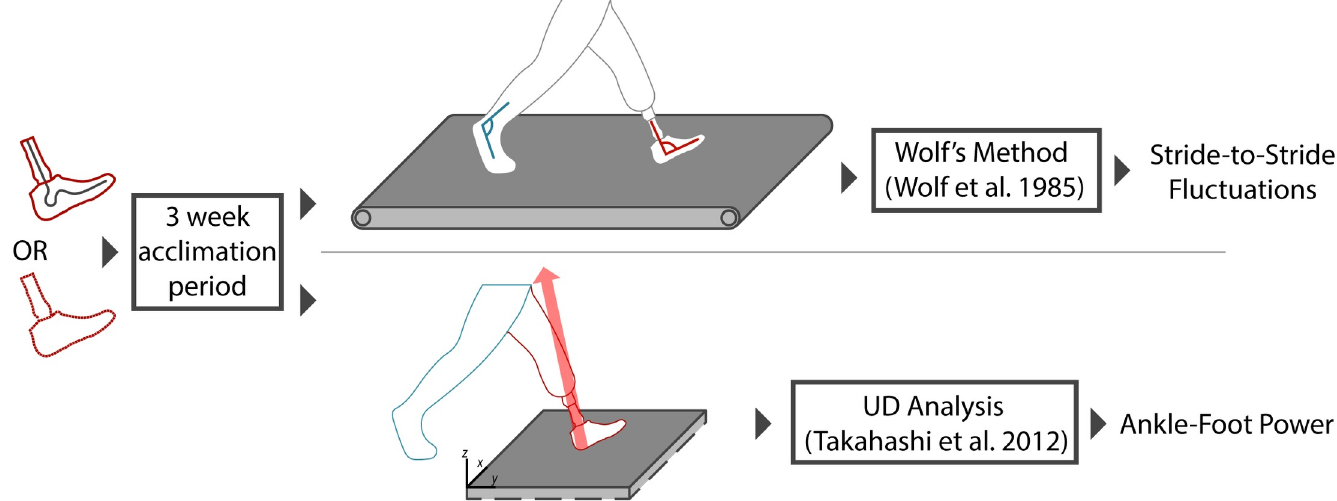
Fig 1. Participants were first fitted with a new prosthetic foot that was classified as either High Activity (HA) or Low Activity (LA) according to the Medicare Functional Classification System. Participants then wore the new prosthetic foot for a period of three weeks to acclimate to the new device. After the three-week period, participants underwent gait analysis during both treadmill and overground walking. Treadmill walking consisted of three minutes at subject-selected speed. Continuous ankle angle data from a single treadmill walking bout (obtained using infrared cameras in conjunction with retroreflective markers on the shoes, prosthesis, and legs) was used to calculate stride-to-stride fluctuations via Lyapunov exponent for both limbs. Overground trials were completed at self-selected walking speed, and force data were recorded using a Kistler force platform to calculate ankle-foot power.